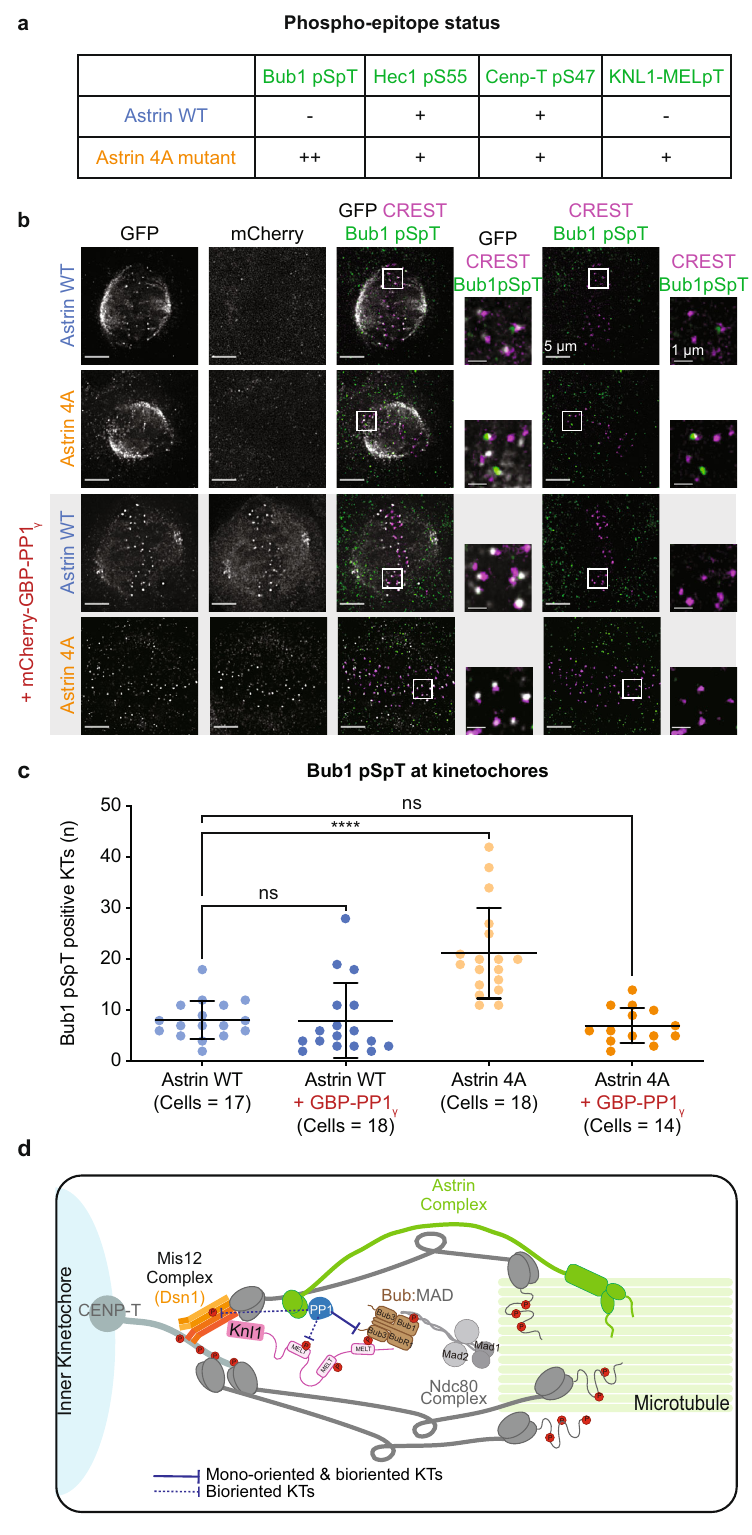
why a reduction in CDK1 activity induces an increase in Astrin 4A levels at the kinetochore is not yet known, Astrin-delivered PP1 counteracts a subset of CDK1-mediated phosphorylation changes at the kinetochore. Collectively, they support our